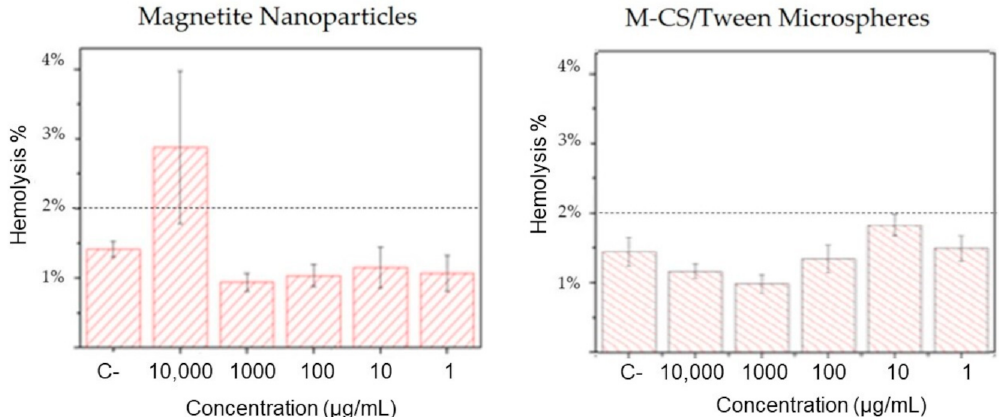
Figure 9. Hemolysis test results of bare magnetite nanoparticles and chitosan/tween 80 microScheme 2016. tested concentrations of 250, 500, and 3000 µ g/mL of bare magnetite nanoparticles, reporting hemolysis rates below 2% at all concentrations [47]. In the present study, concentrations Figure 1 to 10,000 µ g/mL of bare magnetite nanoparticles and M-CS/Tween 80 nanospheres were tested. Hemolysis rates obtained from magnetite nanoparticles are similar to the results of Macias et